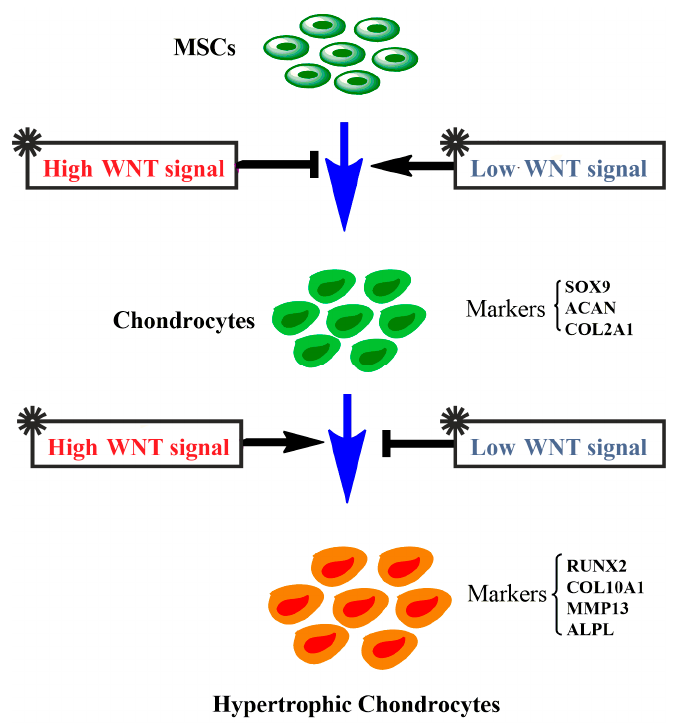
Figure 7. The schematic overview for the chondrogenic differentiation of hMSCs regulated by WNT signaling. High levels of WNT signaling inhibit the chondrogenic differentiation of hMSCs, evidenced by decreased SOX9 , ACAN , and COL2A1 expression, but promote the hypertrophy of chondrocytes, exemplified by the induction of expression of RUNX2 , COL10A1 , MMP13 , and ALPL . In contrast, low levels of WNT signaling promote hMSC chondrogenic differentiation and inhibit chondrocyte hypertrophy.